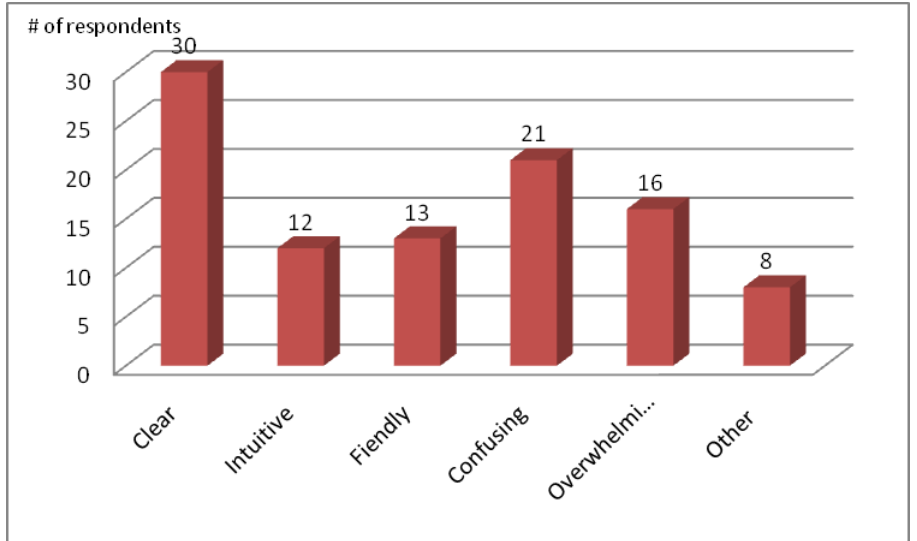
Figure 7 . Opinion on the informational architecture of the course.